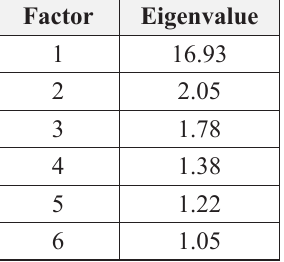
Table 5: Factors with eigenvalues greater than 1 Factor